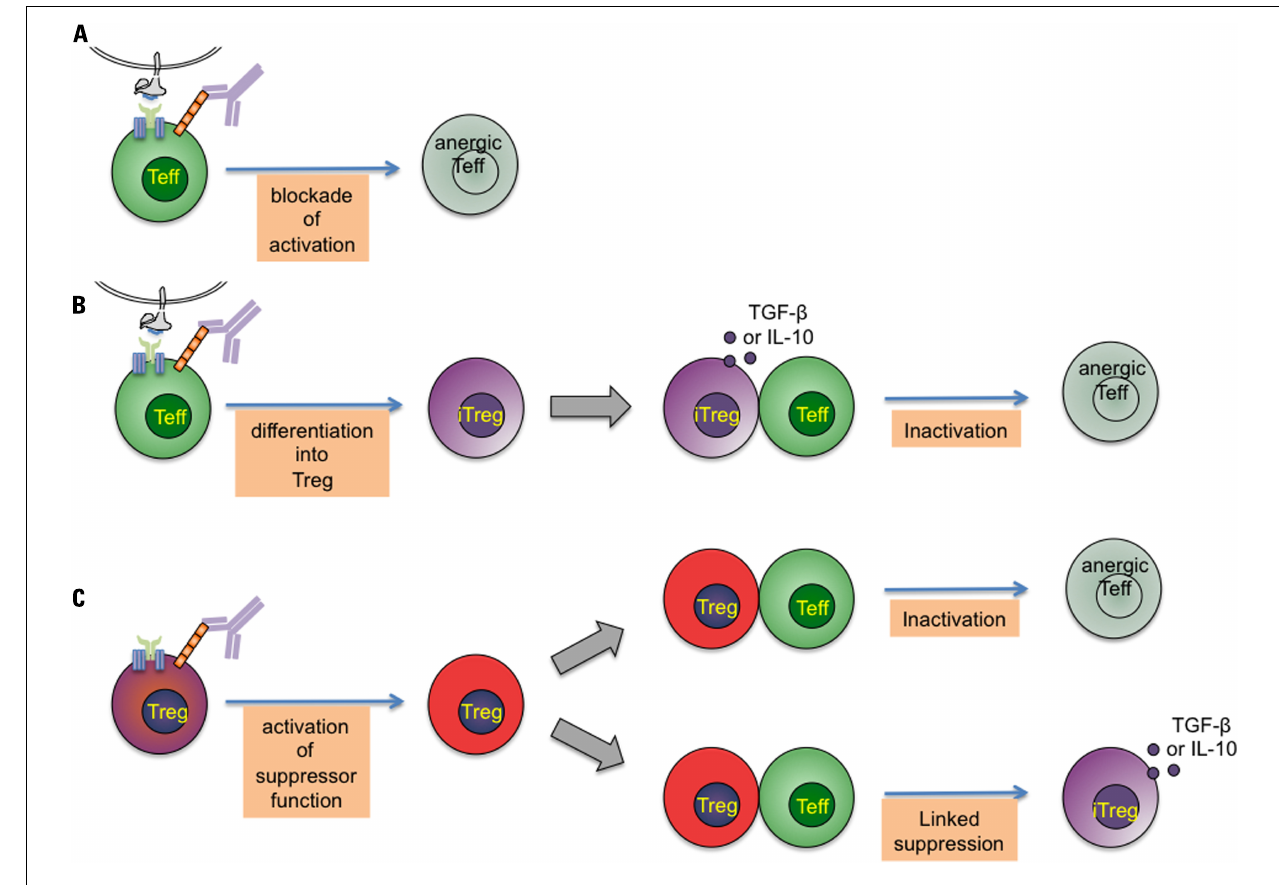
through theT-cell receptor complex resulting in induction ofT cell anergy. (B) By modulating antigenic stimulation, CD4-specific mAb induce differentiation of naiveT cells into adaptive regulatoryT cells, which control pathogenic effectors through transforming growth factor- β (TGF- β ) and IL-10 release. (C) Crucially important for tolerance induction, CD4-specific mAb activate the (cAMP-dependent) suppressive function ofTreg, which, upon activation, exert control on pathogenicT cells by direct and linked